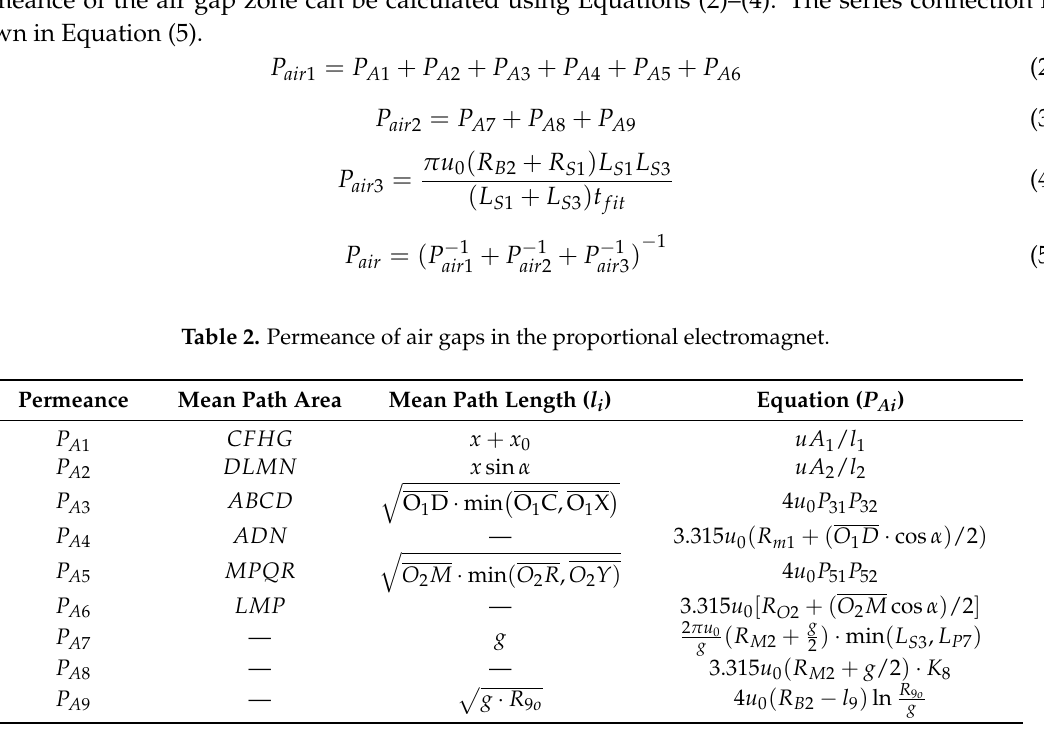
Figure 8. Definition of size for the proportional electromagnet.